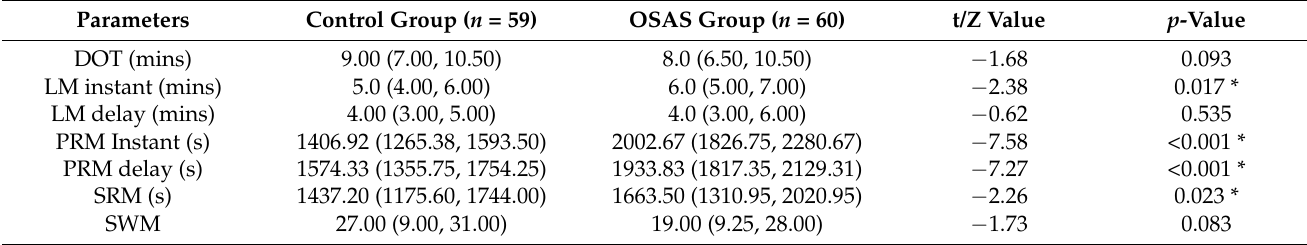
Table 2. Table 2. Memory function results for OSAS and control